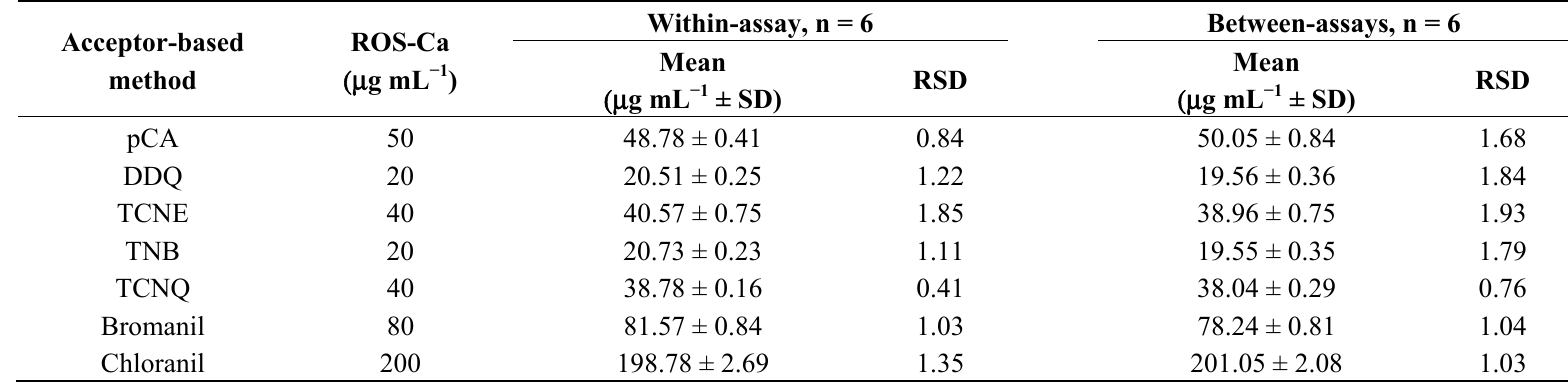
Table 3. Precision of the proposed methods for determination of ROS-Ca based on its CT reaction with different acceptors.